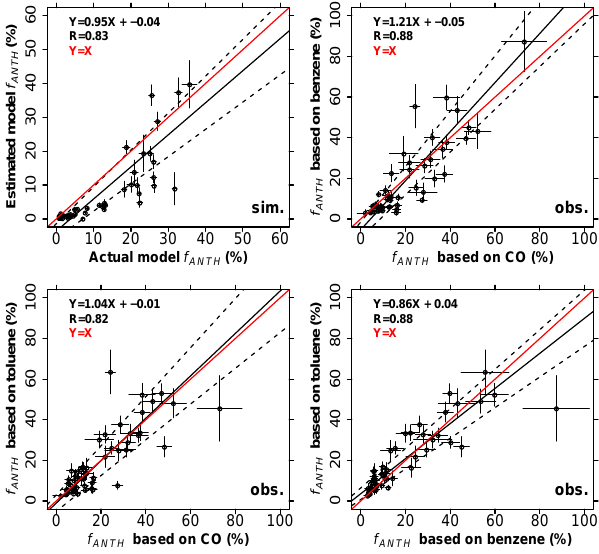
Fig. 6. Top left panel: weekly anthropogenic methanol contribu- tion in the model, estimated using the methanol: CO correlation, compared to the actual model values. The other panels compare the anthropogenic methanol contribution in the observations estimated using the different source tracers (CO, benzene, and toluene). Black solid lines show the best fit (major axis regression), with regression parameters given inset. Black dashed lines show the 95% confi- dence interval for the best fit line. The 1:1 line is shown in red. Error bars show the 95% confidence interval for each weekly me-